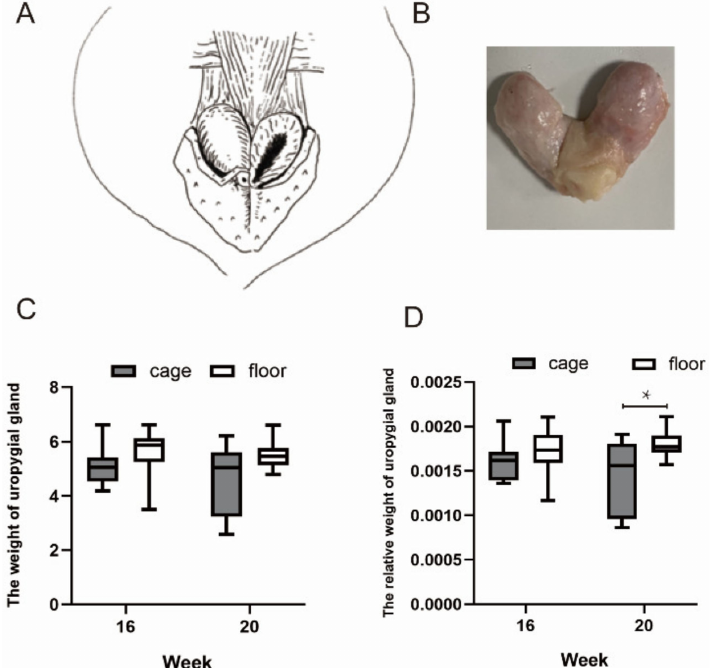
Figure 1. The uropygial glands of ducks. ( A ): Schematic diagram of the anatomical position of duck uropygial glands. ( B ): Image of uropygial glands dissected from a duck at 300 days old. ( C ): The absolute weight of the uropygial glands at 16 weeks and 20 weeks of age under different rearing systems. ( D ): The relative weight (absolute weight of the uropygial glands relative to body weight) of the uropygial glands at 16 weeks and 20 weeks of age under different rearing systems. The * indicate significant differences ( p <